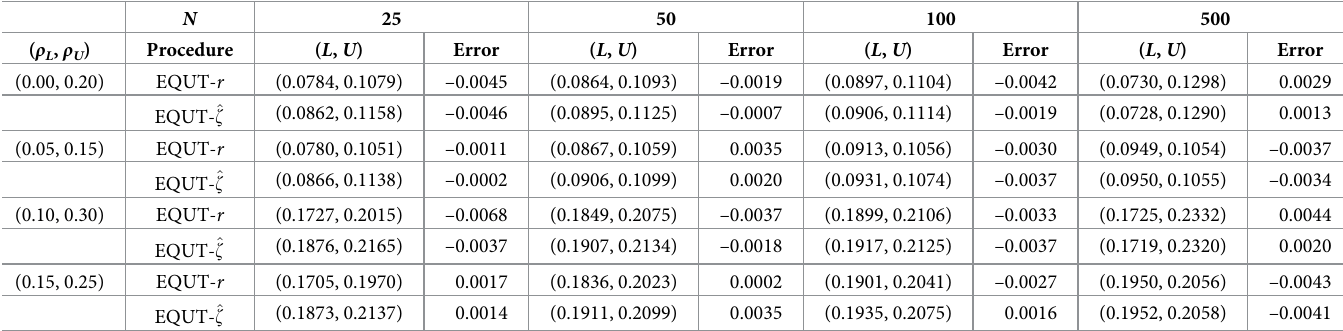
Table 1. The critical intervals and simulated errors of the suggested correlation equivalence tests for α =